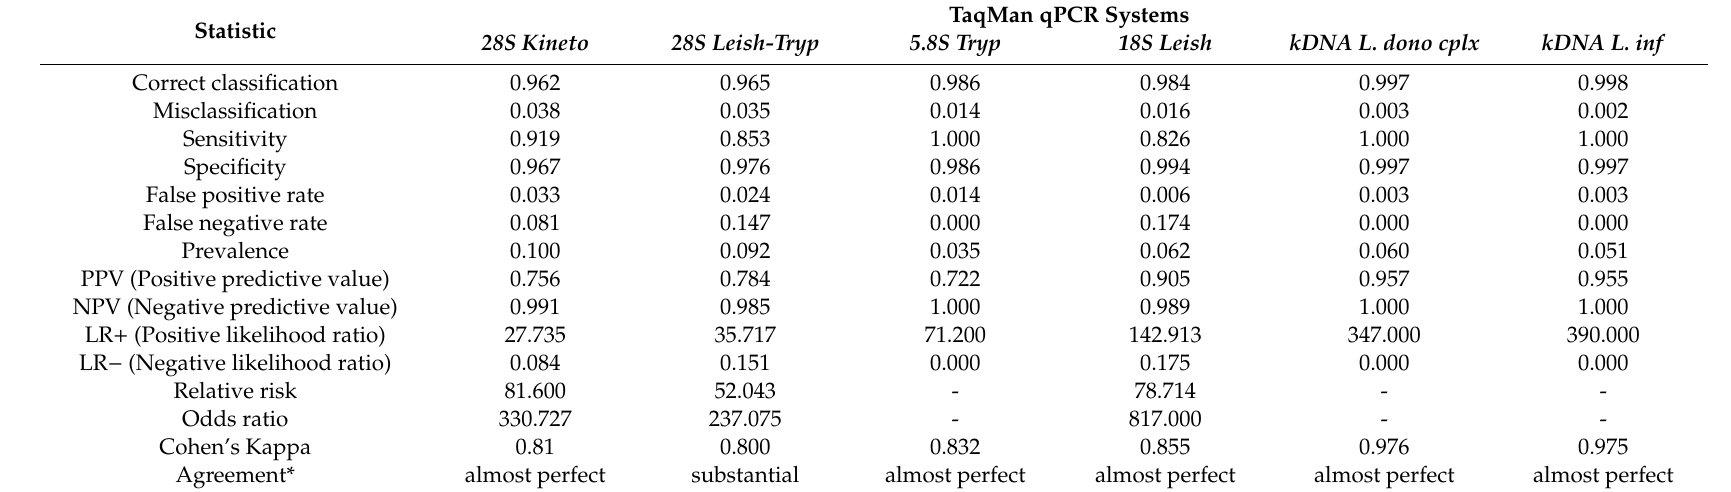
Table 4. Performances of the TaqMan qPCR assays developed in the present study.